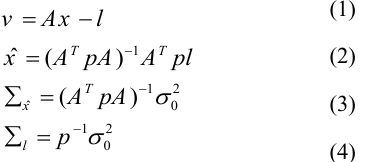
Figure 2 . The point project process used in the simulation